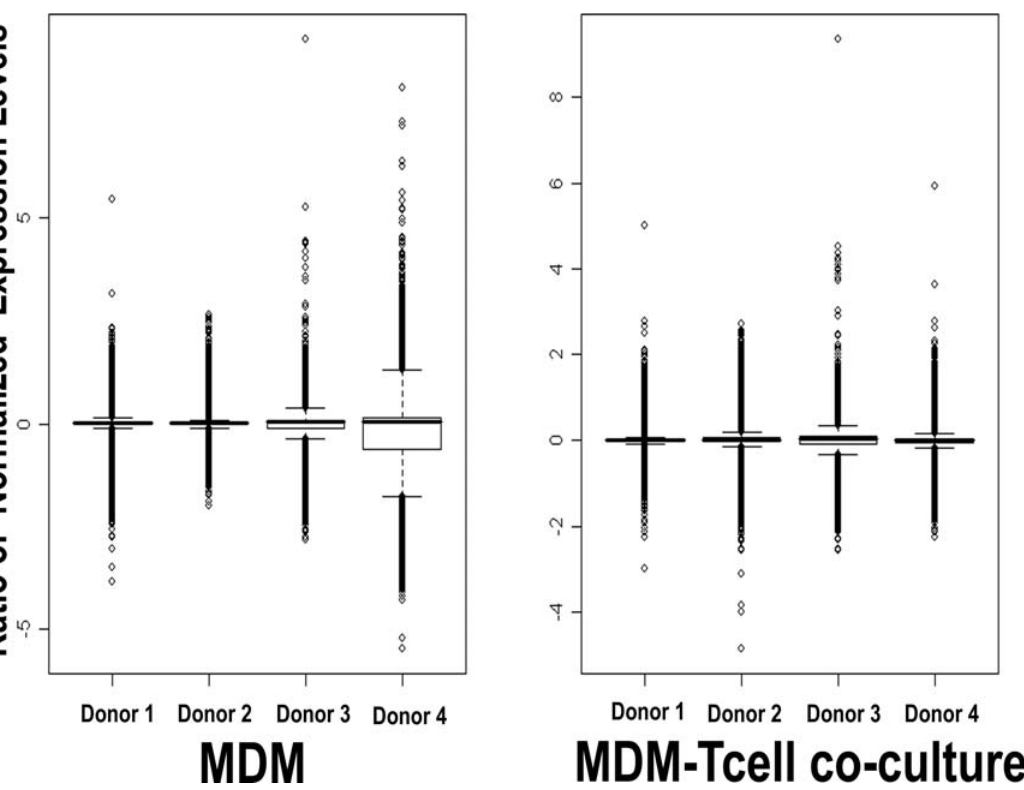
Figure 1. BoxPlot of Ratios [Infected:Uninfected] of gcRMA-transformed microarray expression data. The value of the log 2 (Infected expression value 4 Uninfected expression value) for each probe set in both the MDM only condition and the MDM-T cell co-culture was calculated and plotted separately for each donor. The central box represents the interquartile range and the solid black bar represents the median probe set. Downstream analyses were performed using all four donor data sets.